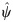
Bias for the conditional Poisson model.(A)-(D) Shown is the bias of the MLE ψ^ in percent as a function of the true parameter ψ based on simulated data created by the conditional Poisson model. Each panel assumes different n and lineage frequency distributions p shown at the top of each panel. Each line is for a different sample size N. (E) Shown is the median bias rather than the mean bias. (F) Average estimates for the lineage frequencies p1 = 0.7, p2 = 0.15, p3 = 0.1 and p4 = 0.05 (marked by the red-dotted horizonal lines) for different sample sizes. Since the lineage-frequency estimates are almost unbiased—independently of the sample size—the lines corresponding to different N almost coincide. Hence, only the top lines (purple lines for N = 200) at p1 = 0.7, p2 = 0.15, p3 = 0.1 and p4 = 0.05 and the dotted red lines on top are visible.